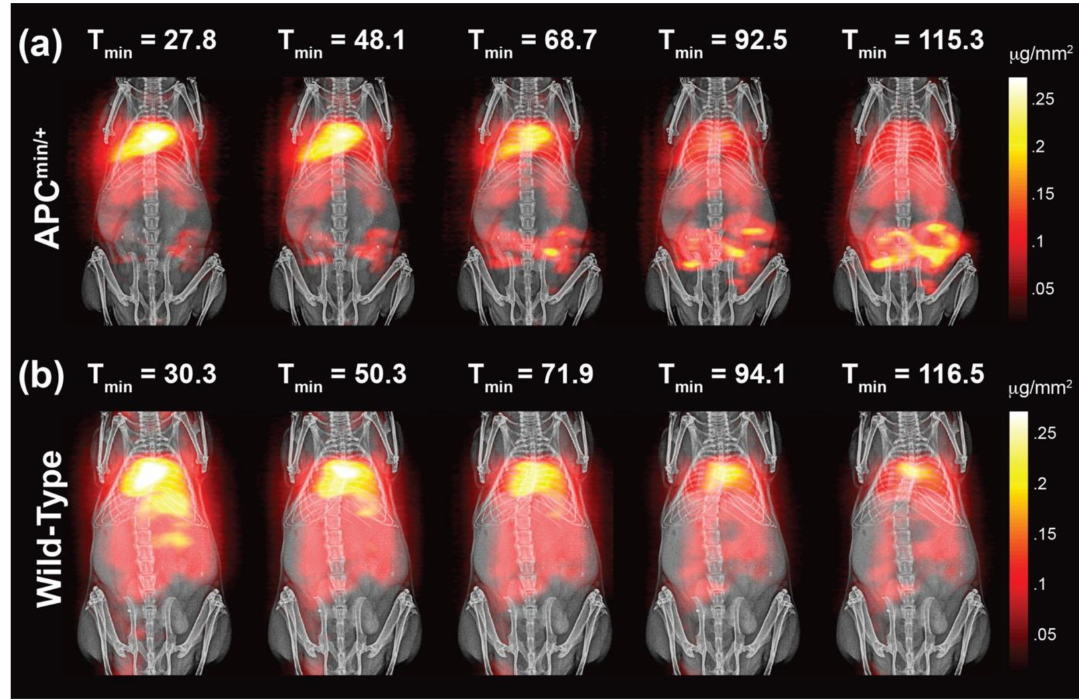
Figure 3. The imaging results of MPI coregistered with projection X-ray capture whole-body tracer biodistribution. ( a ) MPI shows the dynamics of tracer extravasation into the gut of an ApcMin /+ mouse over time. ( b ) No tracer extravasation into the gut is captured in the MPI images of a wild-type mouse over time. Image reproduced, with permission, from Reference [51]. Copyright 2017 American Chemical